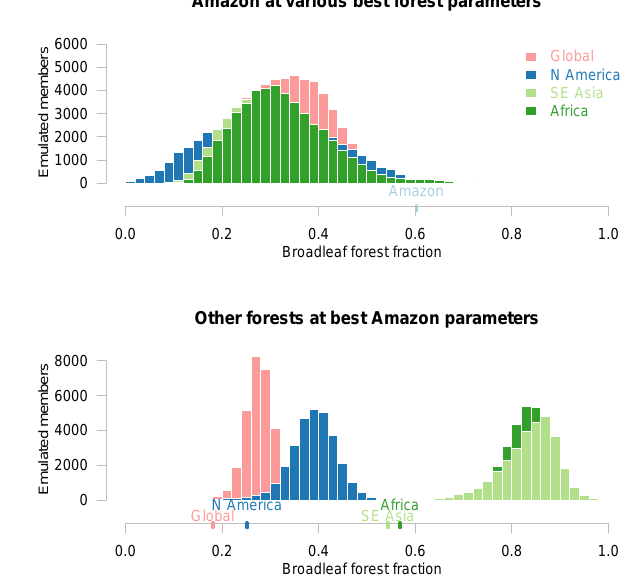
Figure 11. Top panel: forest fraction in the FAMOUS Amazon at the set of parameters where FAMOUS best matches each of the other forest observations. Bottom panel: other forests in FAMOUS at the set where the FAMOUS Amazon best matches observations. Observed forest fractions are shown as marks underneath the his- tograms.